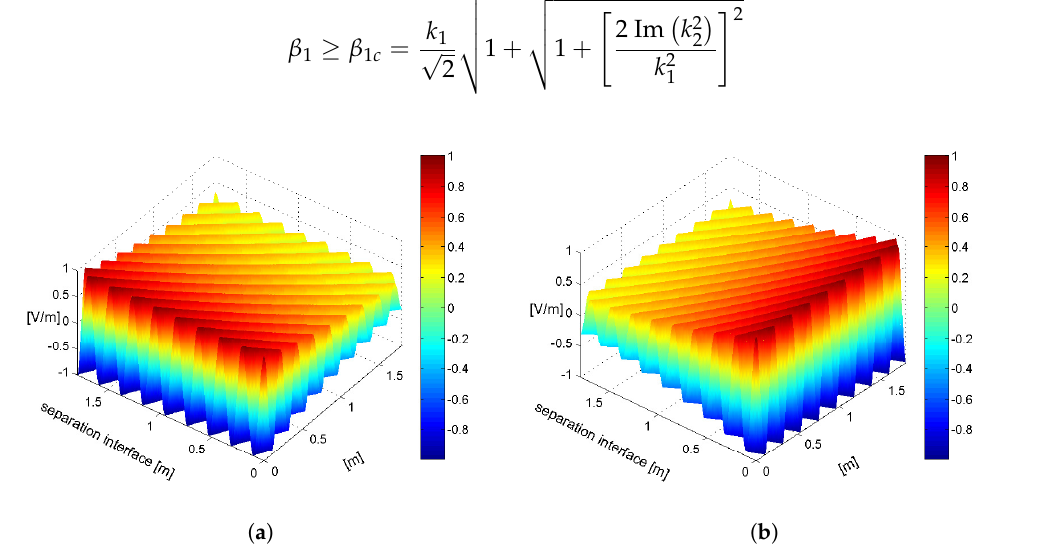
Figure 2. Plane wave of 1 V amplitude and 1 GHz frequency, propagating in a lossy medium with permittivity ε = 4 ε 0 , permeability µ = µ 0 , and σ = 0.005 S/m. A propagation angle of 45 ◦ with respect to the plane separation surface is considered here. In both figures, the vertical axis represents the field amplitude, expressed in V/m, while the other two axes represent the separation surface [m], and the direction orthogonal to the separation surface [m], respectively. The vertical gradient bar, on the right-hand side of both figures, associates different colors to different amplitudes of the electric field. ( a ) wave in a lossy medium: attenuation vector normal to the separation surface; ( b ) wave in a lossy medium: attenuation vector parallel to the separation